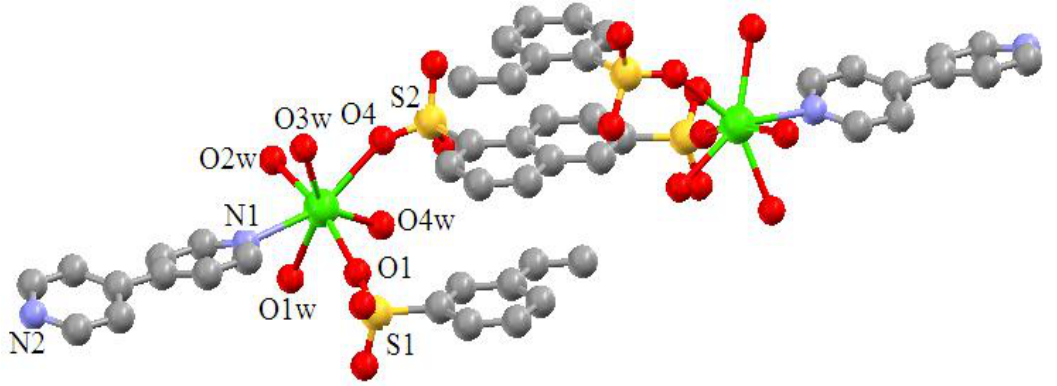
Figure 1. Coordination environment around the Ca(II) center in the coordination polymer.